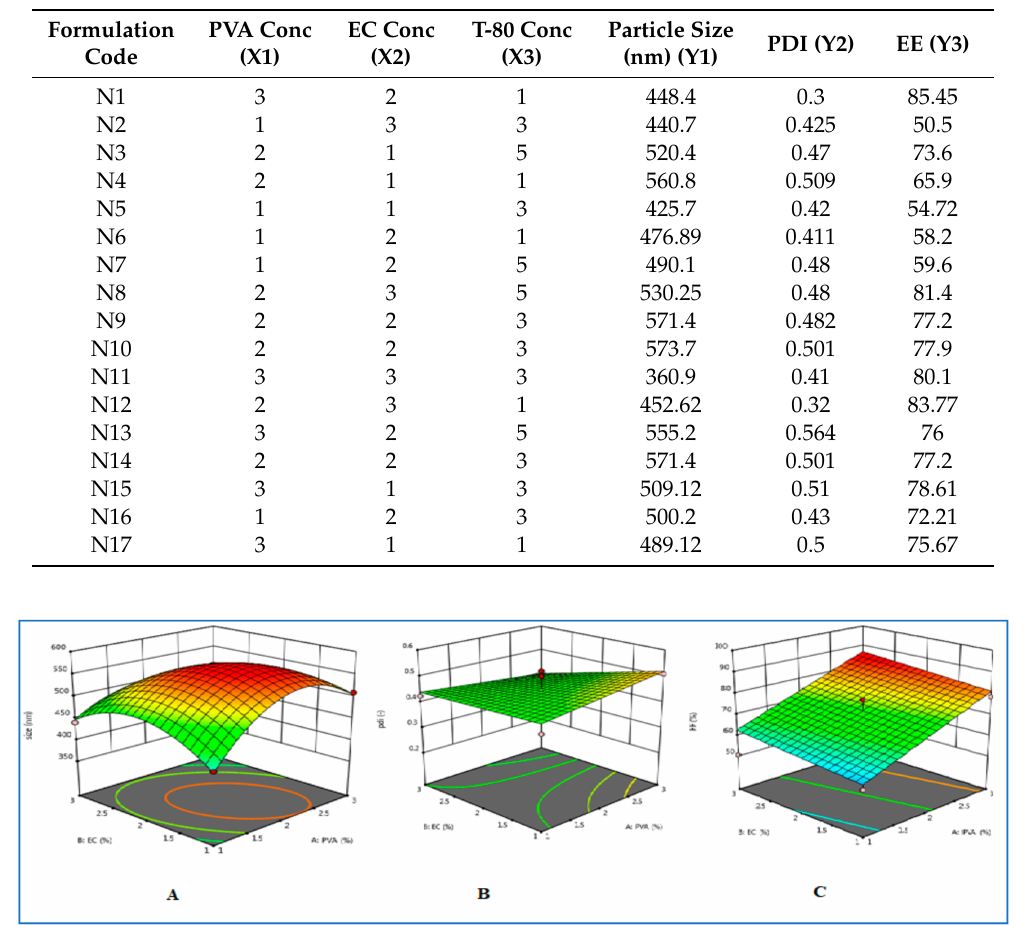
Table 3. Experimental runs of BBD with obtained results.